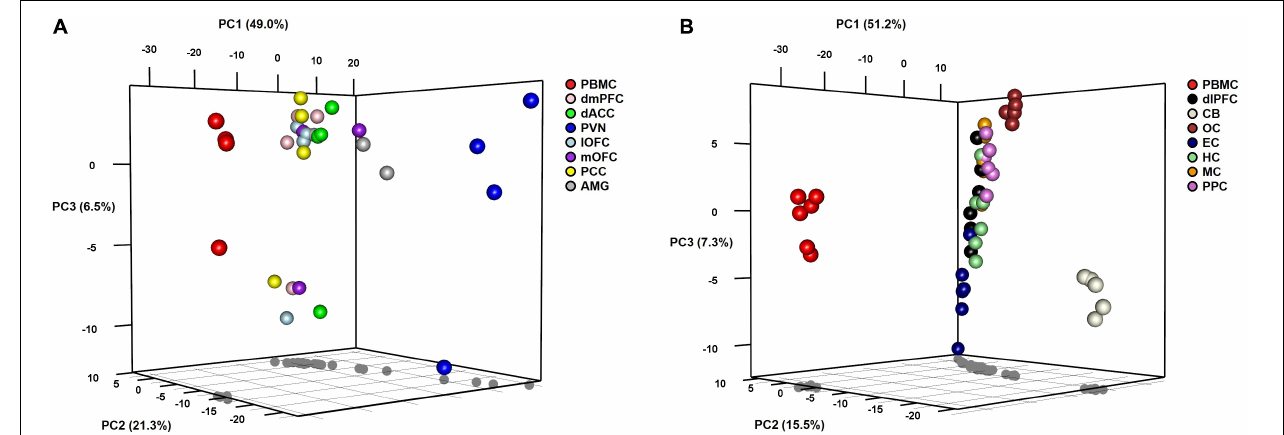
FIGURE 2 | 3D plots of results from principal components analyses of miRNA expression levels in baboons by tissue type in (A) Group A animals and (B) Group B animals.